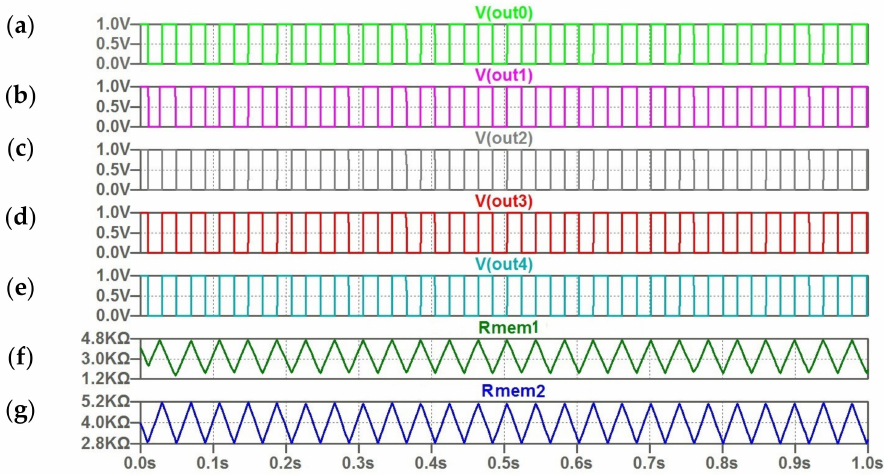
Figure 10. ( a – g ) The computed waveforms for five coupled oscillators; ( f , g ) the triangular character of change memristor resistances R (t) for the first and second